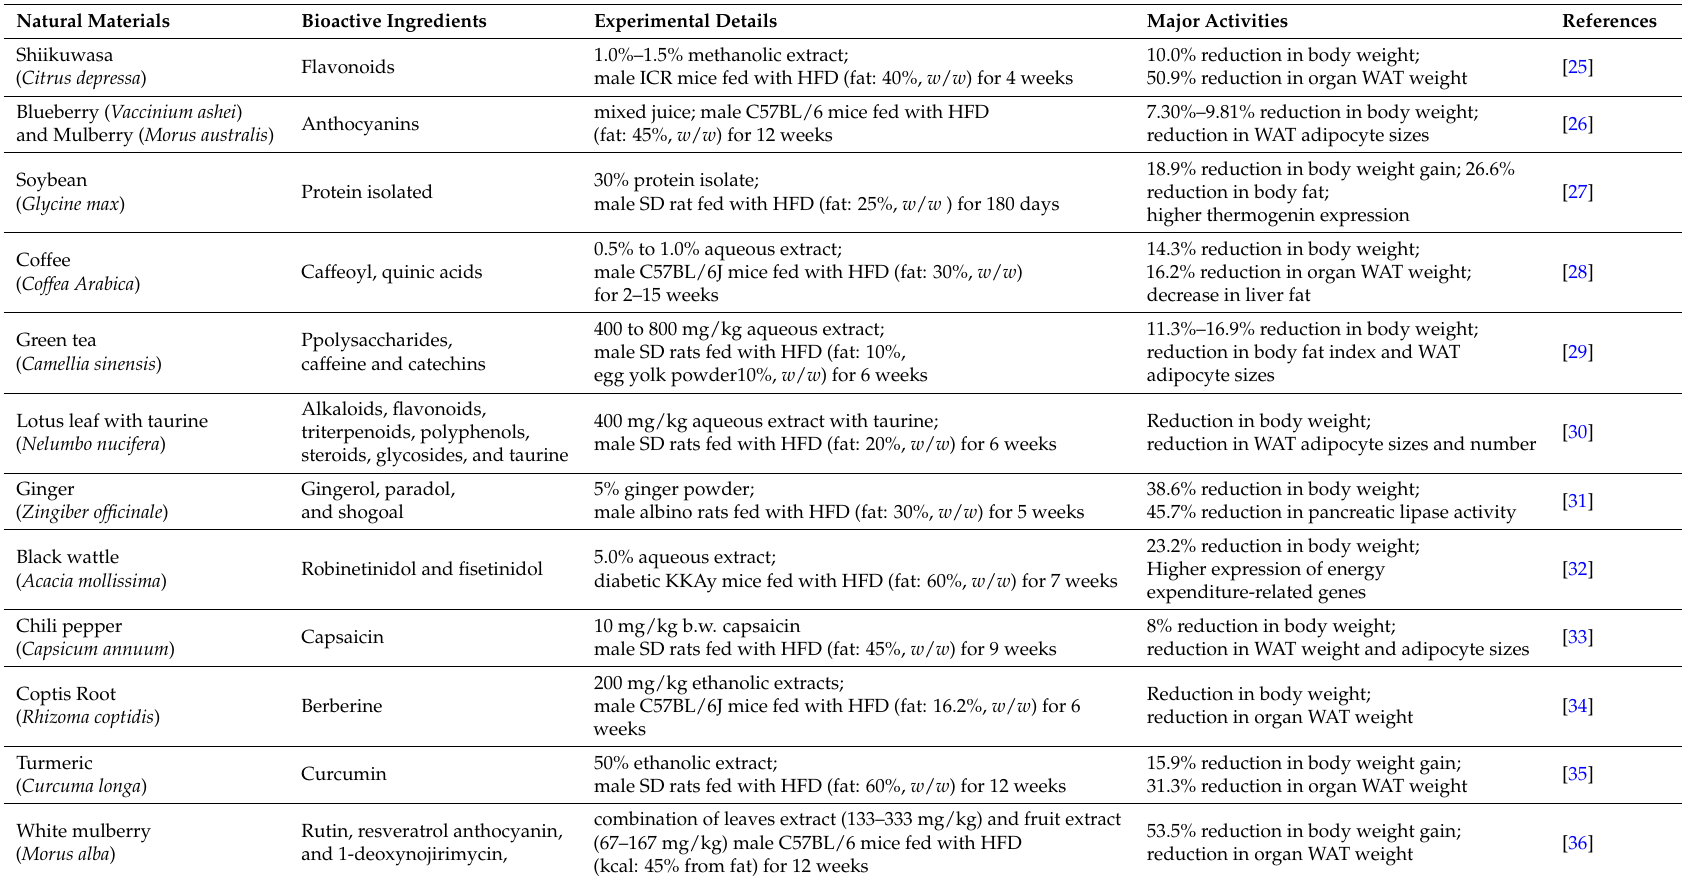
Table 1. Summary of natural materials and ingredients with potential anti-obesity